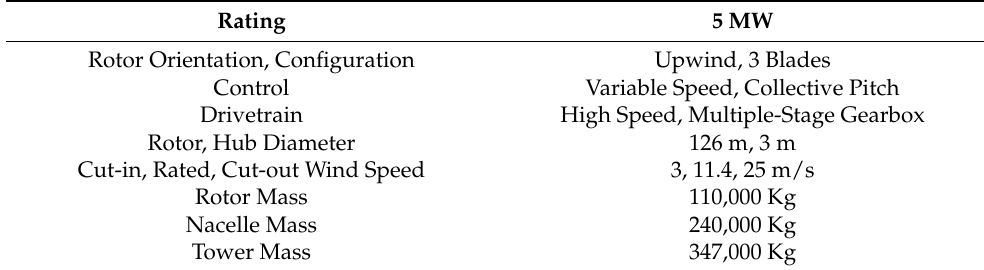
Table A1. General characteristics of the NREL 5MW turbine [11].